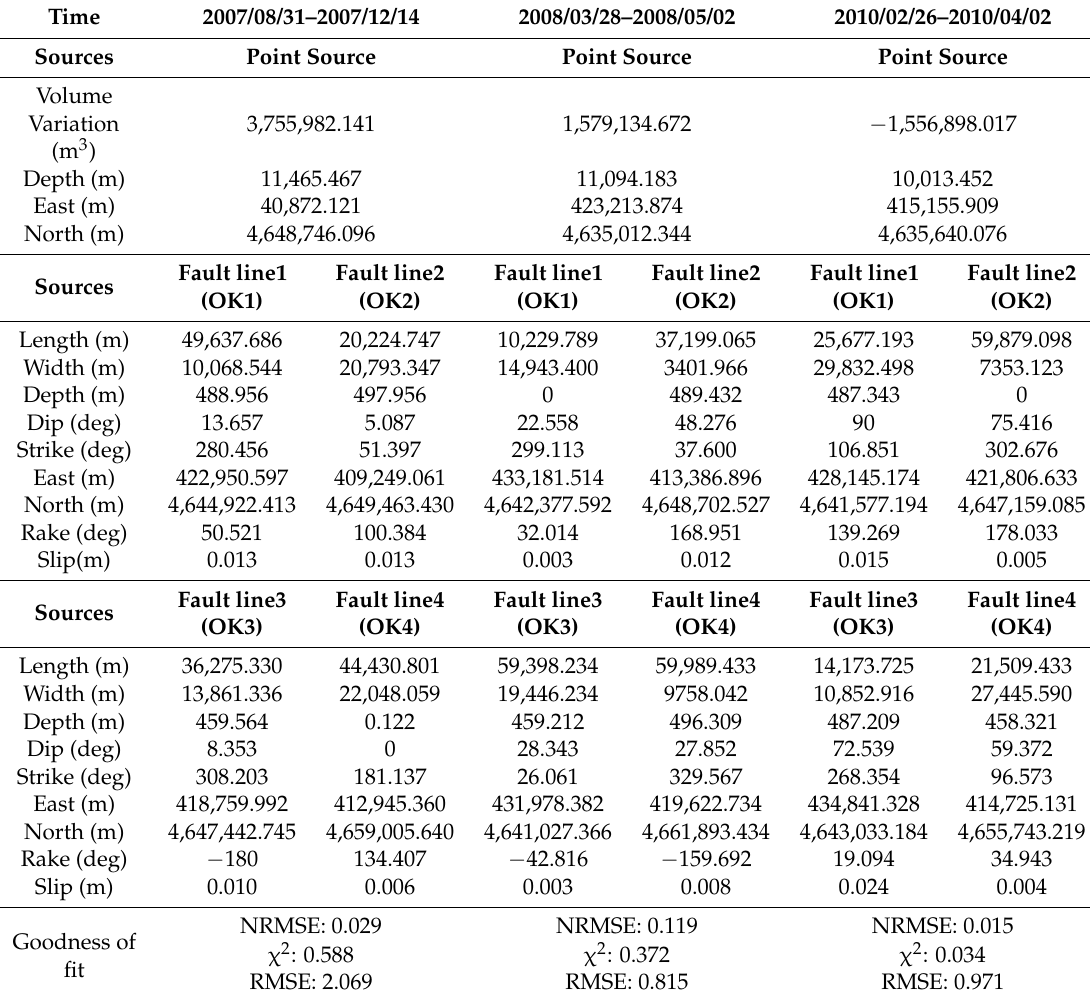
Table 3. Source parameters determined by inversion. See Figure 12 for location of deformation sources (OK1 to OK4).